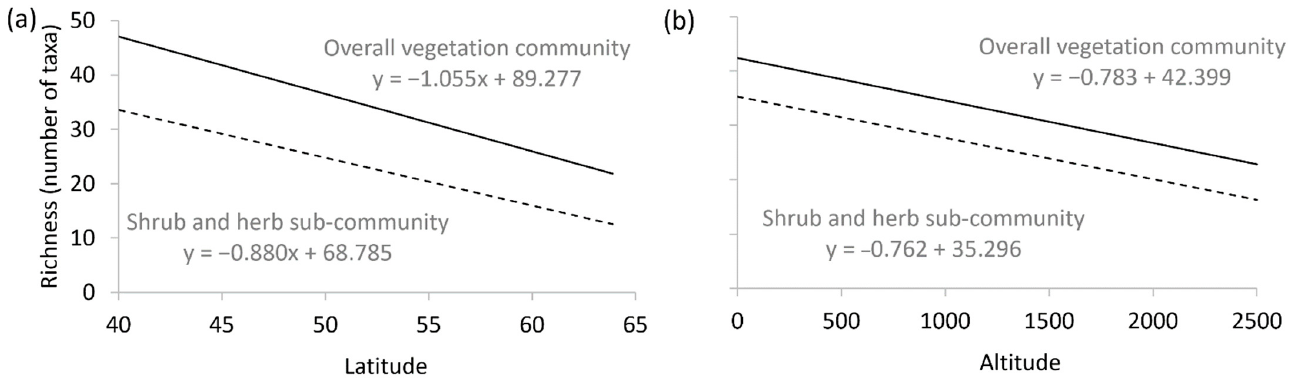
Figure 2. Schematic of the relationship between taxonomic richness in the overall vegetation commu- nity (solid line) and the shrub and herb sub-community (dashed line) at 23 sites in western Eurasia for: ( a ) latitude; and ( b ) altitude. The equations were calculated using regression analysis on raw data (n = 867 for overall vegetation community and 866 for shrub and herb sub-community) and values show the change in richness per 1 ◦ increase in latitude and per 100 m increase in